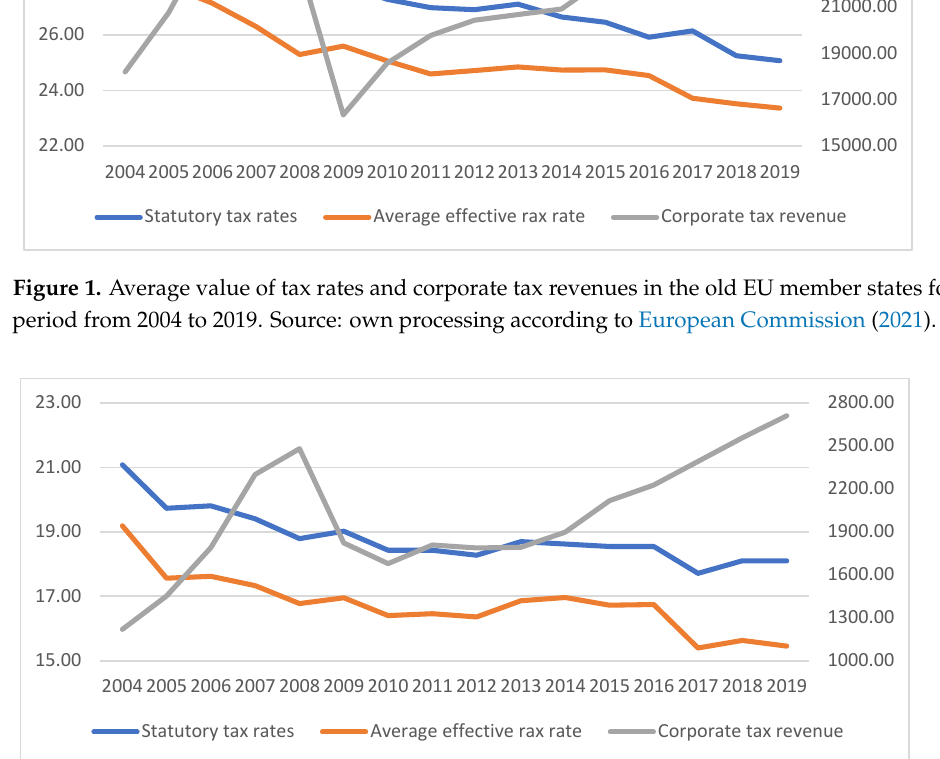
Figure 2. Average value of tax rates and corporate tax revenues in the new EU member states for the period from 2004 to 2019. Source: own processing according to European Commission (2021).